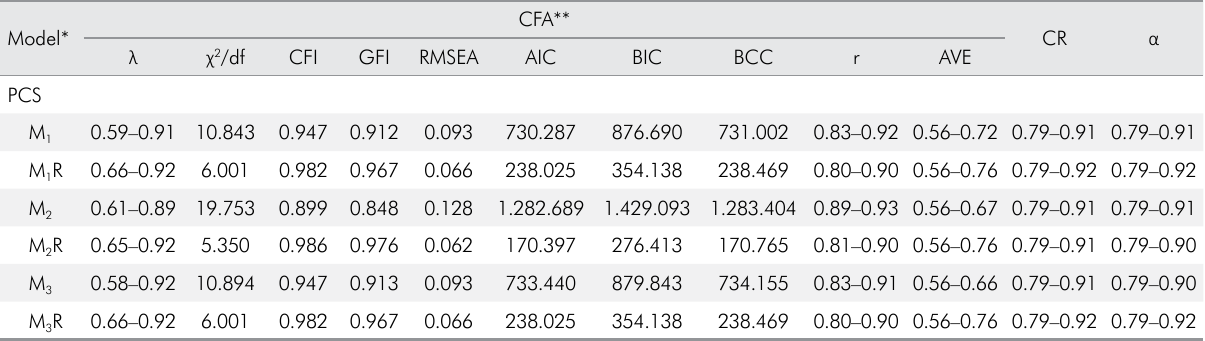
Table 4. Confirmatory factorial analysis (CFA), average variance extracted (AVE), and reliability (CR, α ) of the Pain Catastrophizing Scale (PCS) fit for the sample.